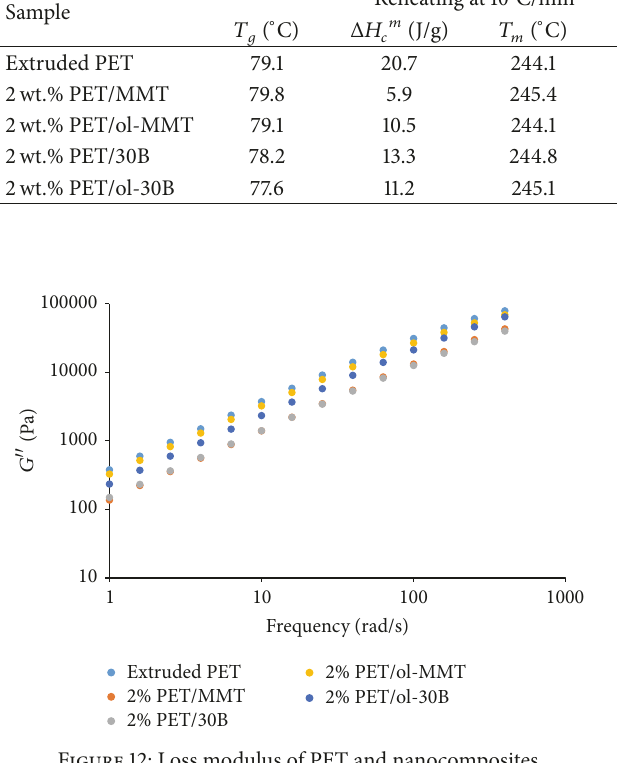
Figure 12: Loss modulus of PET and nanocomposites.